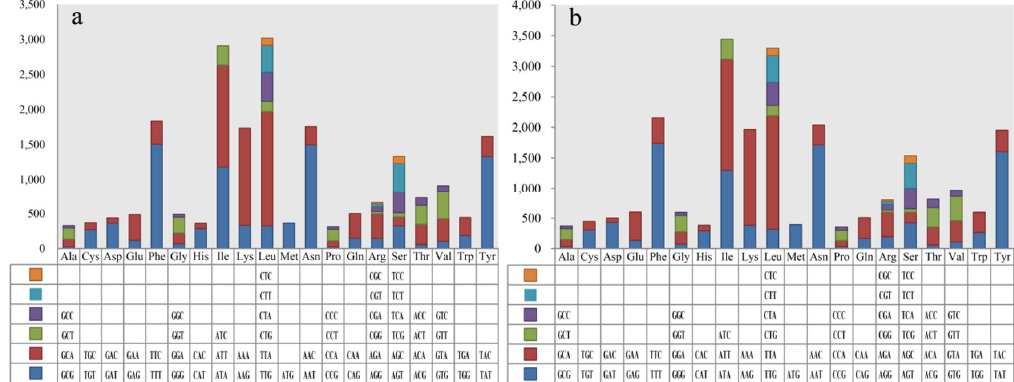
Figure 4. Codon usage in the mitogenomes of two Rhizopogon species. Frequency of codon usage is plotted on the y-axis. ( a ) R. salebrosus ; ( b ) R. vinicolor .